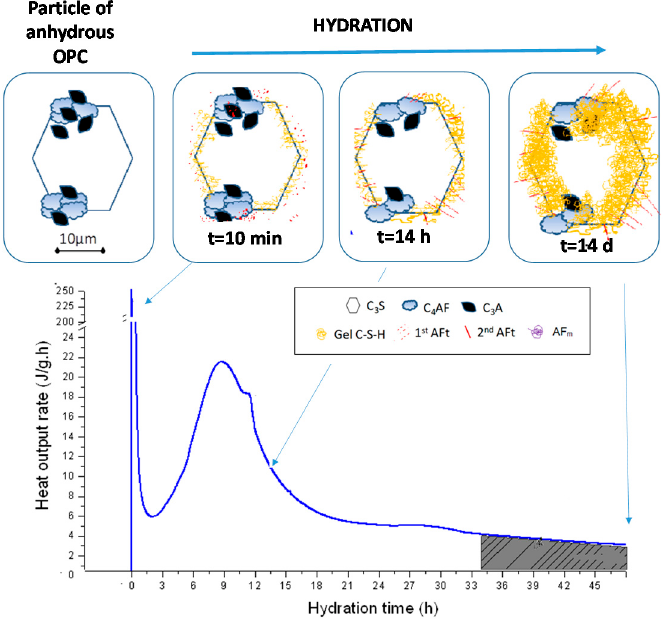
Figure 2. Descriptive model for poly-phase OPC grain hydration and a typical calorimetric curve for OPC hydration (grain drawings adapted from Scrivener as quoted in Taylor (1997) [27]).